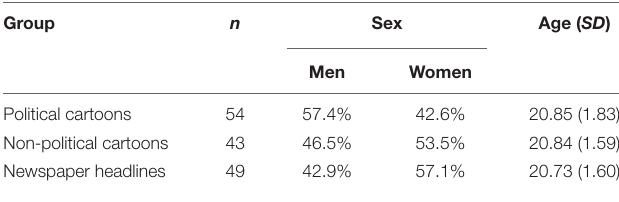
TABLE 5 | Sex and age descriptive statistics for the three groups Study 2.